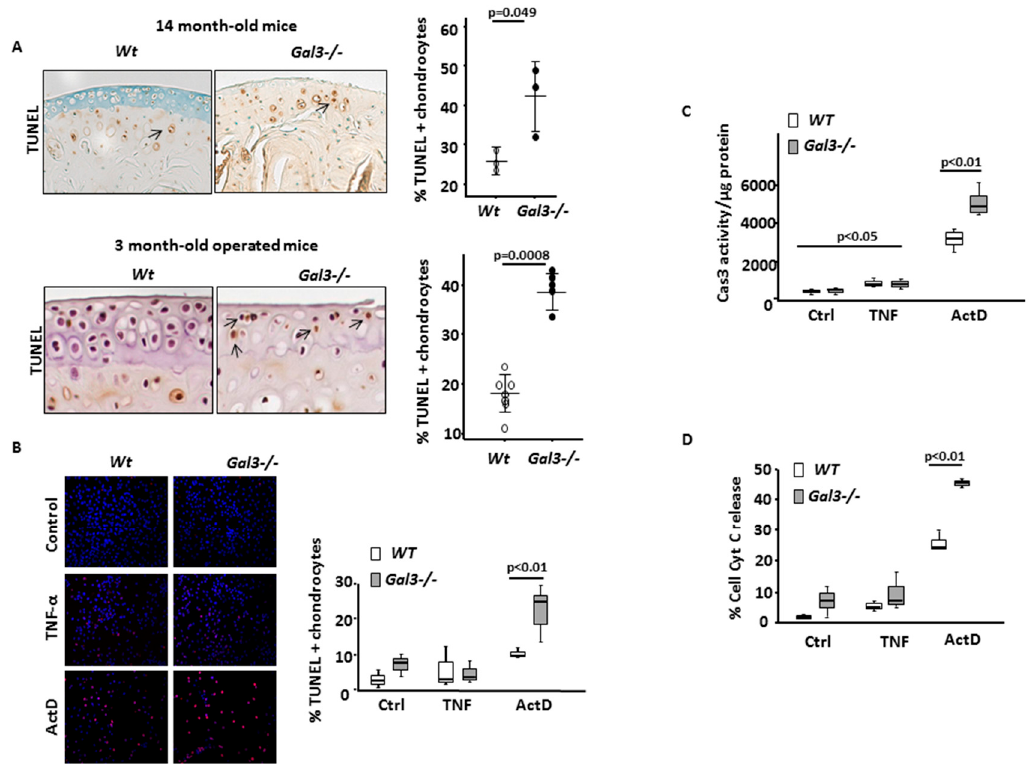
Figure 5. GAL3 deletion induces chondrocyte apoptosis via mitochondrial pathway. ( A ) Ex vivo, chondrocyte apoptosis was assessed by TUNEL labeling in 14-month-old mouse cartilages ( n = 3 WT and Gal3 − / − mice) (left and top panel) and 3-month-old mouse cartilages after MNX ( n = 8 WT and Gal3 − / − mice). ( B ) In vitro, articular cartilage chondrocytes from Gal3 − / − and WT newborn mice were stimulated with TNF- α (20 ng / mL) or actinomycin (ActD, 50 nM) or left untreated (Ctrl) ( n = 3 independent experiments). Percentage of TUNEL positive chondrocytes (A and B, right panels). ( C ) Caspase 3 (Cas3) activity (expressed in arbitrary units (AUs)) assessed 48 h after stimulation with TNF- α or ActD and normalized for protein contain. ( D ) Percentage of cytochrome c (Cyt c) release in chondrocyte cultures assessed by immunostaining and fluorescence microscopy. Scale bars: 100 µm. Horizontal bars were medians, box edges are Q1–Q3 and whiskers are range. Two-tailed Mann–Whitney U test between WT and Gal3 − / − .